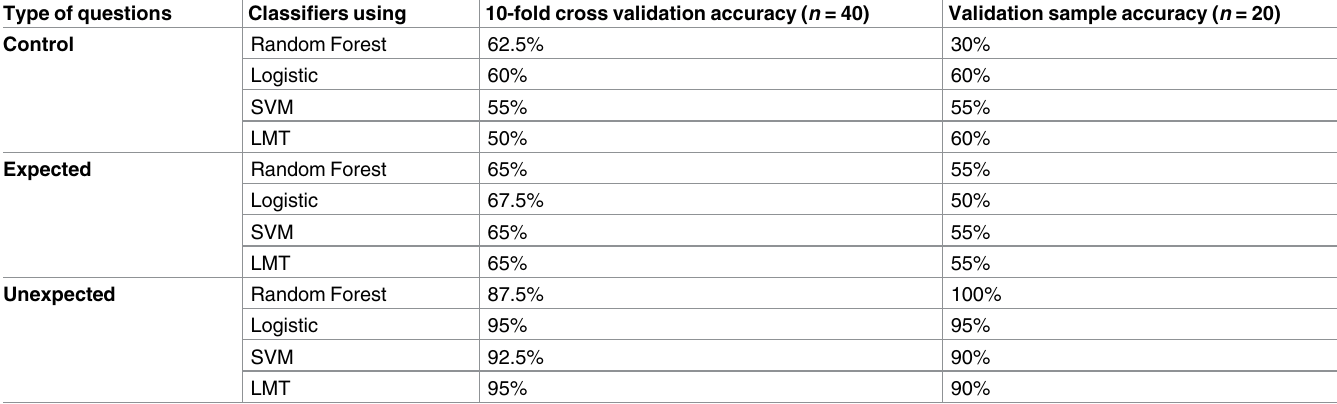
Table 6. Classification accuracyfor control, expected, and unexpected